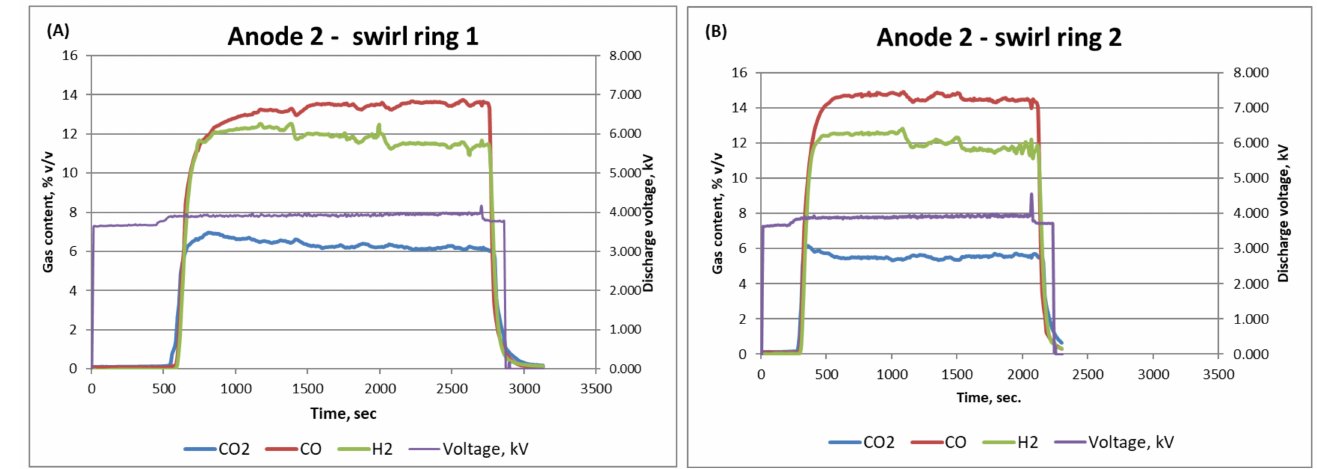
Figure 10. Comparison between Ring 1 ( A ) and Ring 2 ( B ) with Anode